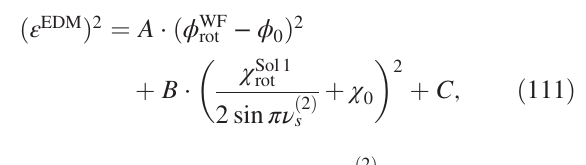
FIG. 20. Panels (a) and (b) show the resonance strengths ε EDM as defined in Eq. (106) on a grid in the range ϕ WF ¼ ½ − 0 . 1 ° ; … ; þ 0 . 1 ° (cid:2) with an assumed EDM of d ¼ 10 − 18 e cm. Each point in panels (a) and (b) is obtained from a calculation and χ Sol 1 rot ¼ 200000 and n ¼ 100 . with n turns points